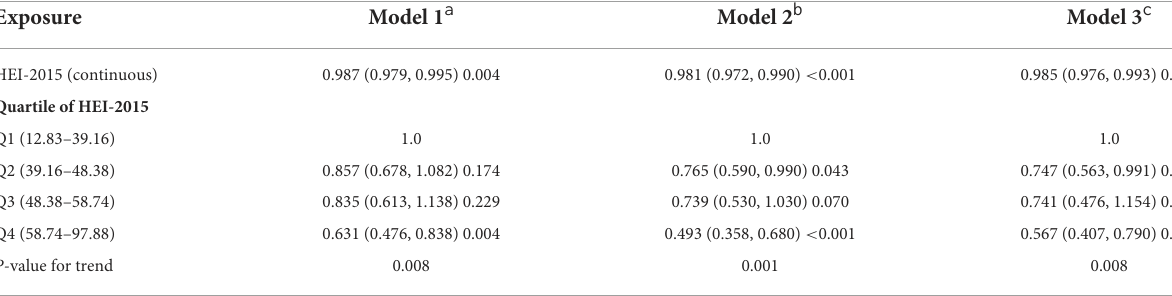
TABLE 2 Association of Healthy Eating Index 2015 with